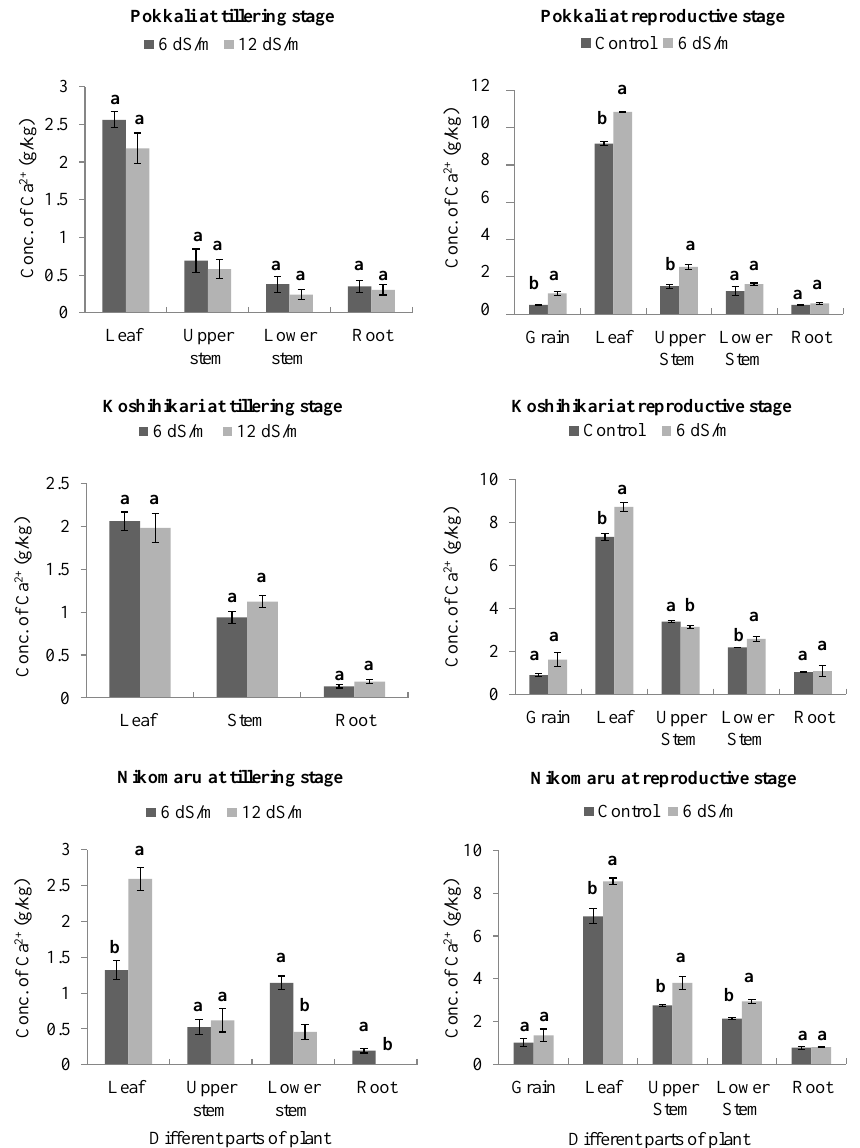
Figure 4. Average concentration of calcium ions in different parts of the rice plant body in the tillering stage (under 6 and 12 dS/m saline irrigation) and in the reproductive stage (under control and 6 dS/m saline irrigation). Error bars represent standard errors ( n = 6). Different letters on bars indicate statistical difference at p ≤